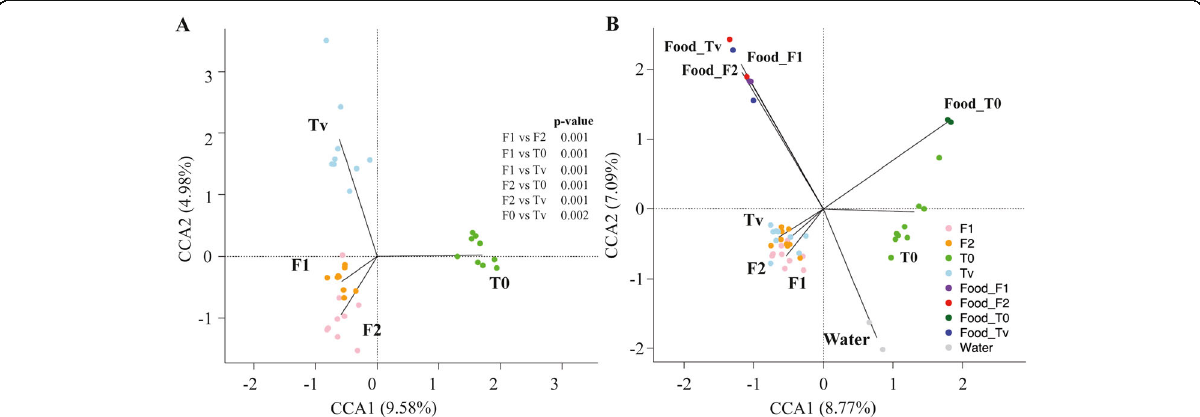
Fig. 2 Canonical Correspondence Analysis (CCA) for A , gut microbial composition comparisons between rainbow trout fed four different dietary protein sources for three months ( n = 9 fish/diet); and B , sample types including microbial structure associated to each food and raising water. Each dot represents an individual sample plot according to its microbial profile at the ASV level. Results of Permutational multivariate analysis of variance (PERMANOVA) coupled with the Bray-Curtis dissimilarity matrix are reported. Significance was set at p < 0.05. T 0 : commercial fishmeal-rich diet; Tv: full terrestrial plant-based diet devoid of fishmeal; F1: plant-based diet in which 11% of plant proteins have been replaced by 5.5% of proteins from yeast (YEA) and 5.5% of proteins from insect larvae (INS); F2: plant-based diet in which 16.5% of plant proteins have been replaced by 5.5% YEA, 5.5% INS and 5.5% processed animal proteins